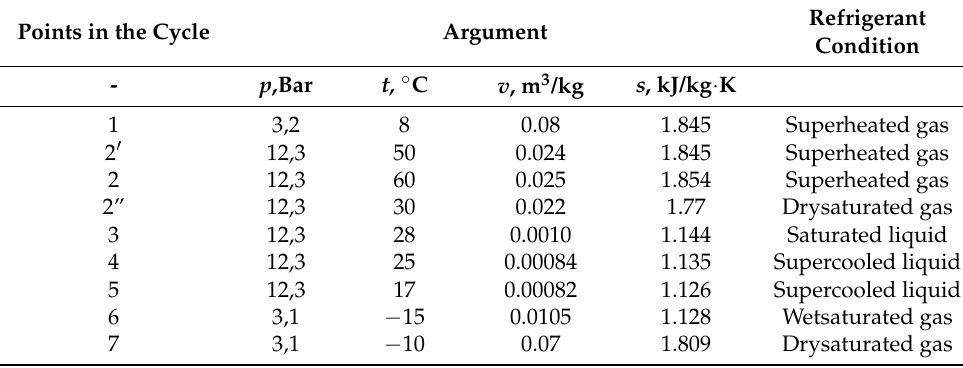
Table 2. Refrigerant parameters at specific points in the cycle.